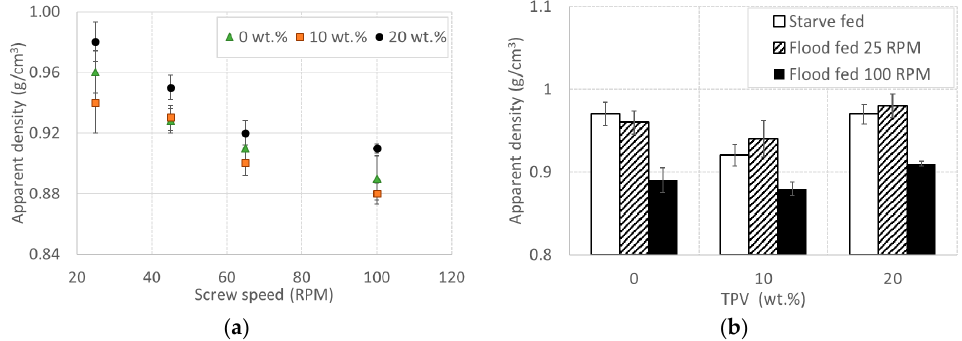
Figure 5. Apparent density ( a ) vs. screw speed for all materials in a flood fed condition and ( b ) vs. content of TPV in a starve fed condition at 100 RPM, flood fed condition at 25 RPM, and flood fed condition at 100 RPM. Error bars indicate the standard deviation.